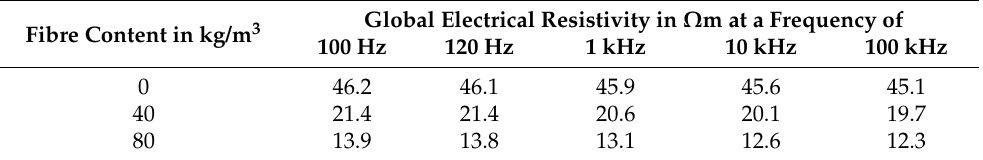
Table A36. Results of the resistivity measurements of the concrete mixture 32-60-300-00 after storage in H2O for 14 days for the investigations of possible leaching effects.